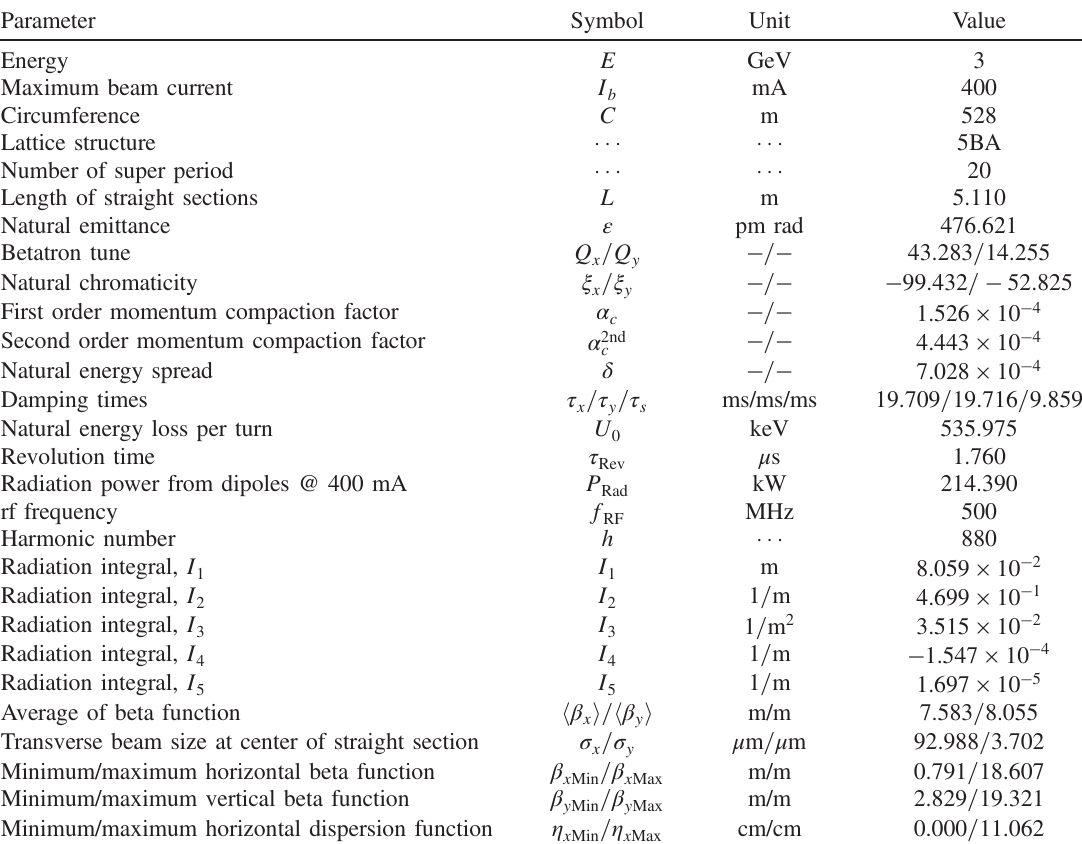
TABLE I. Main ILSF storage ring parameters. The subscripts x , y and s indicate horizontal, vertical and longitudinal directions